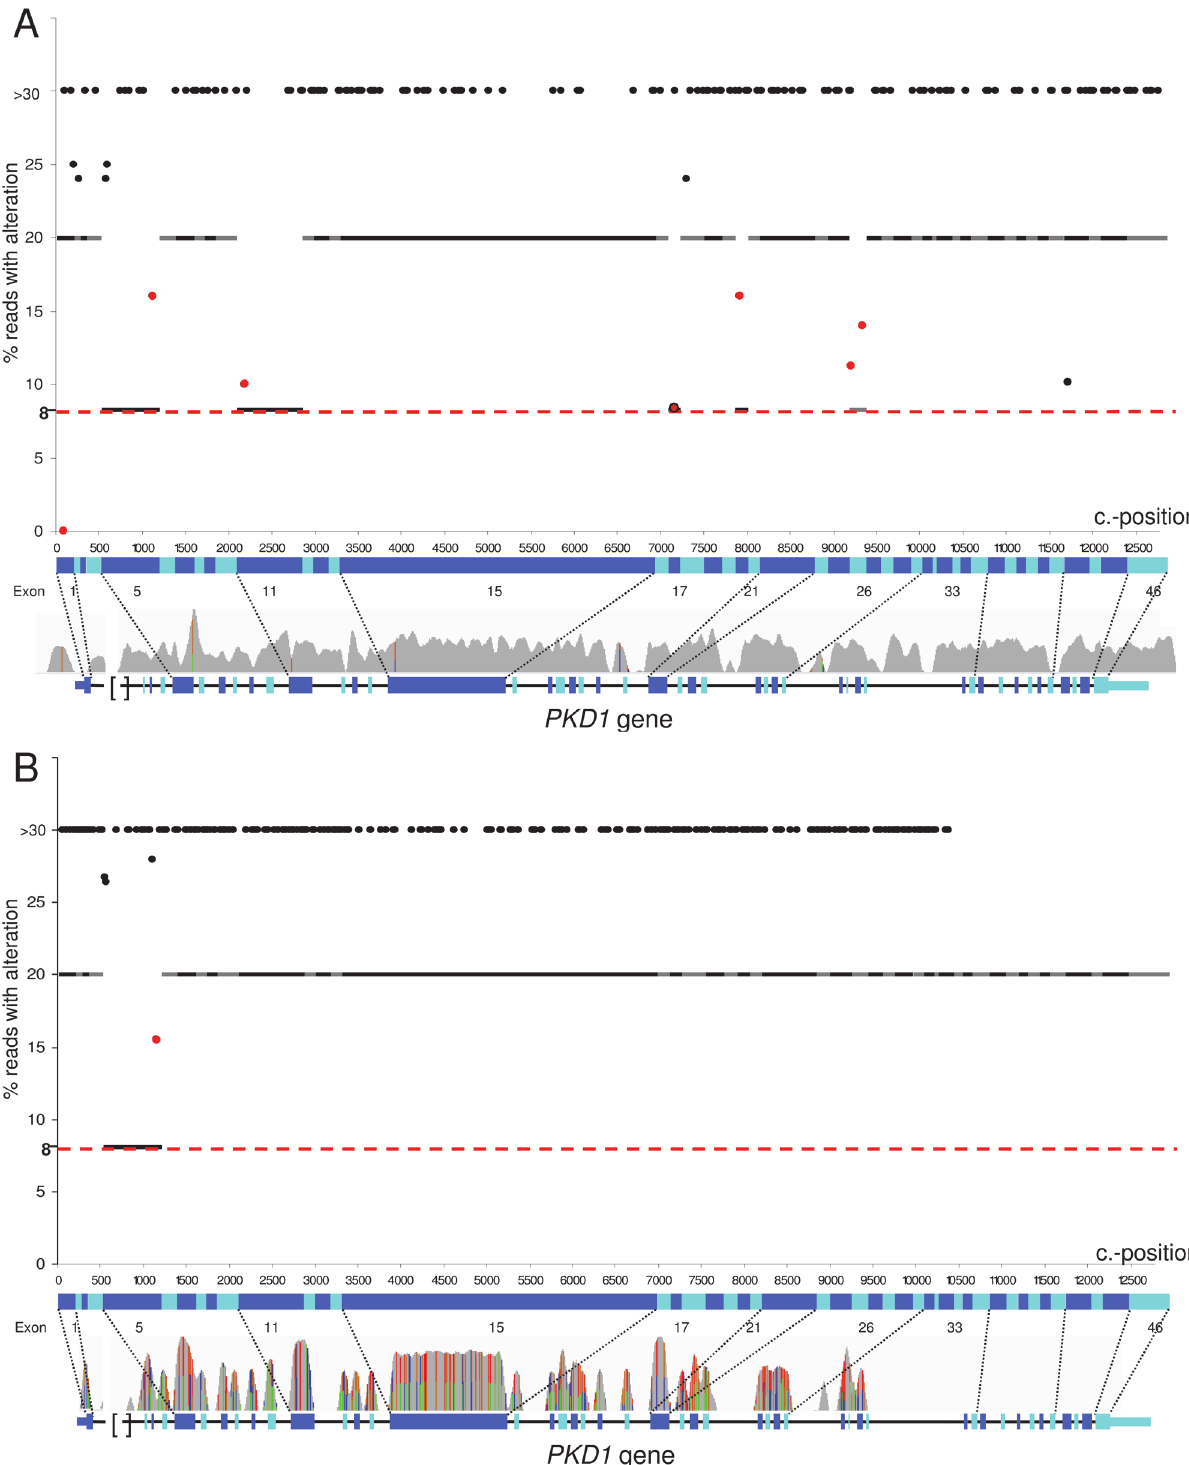
Fig 2. Detection level and distribution of PKD1 variants in our cohort and by variant simulation. A Percentage of alternative reads detected by our NGS approach for all PKD1 variants (black dots) from our cohort is displayed. All except seven variants could be detected above the standard detection threshold (black/grey lines displaying exon boundaries). The variants highlighted with red dots lie in the duplicated region and required second-step analysis with a lower detection threshold (8% alternative reads, red dashed line) to be detected in these critical exons. One variant in exon 1 could not be detected due